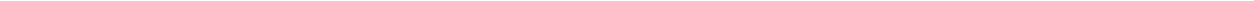
Fig. 7 FGF signaling differentially affects tbx1 + ventricular and BA precursors. a – f Maximum intensity projections of representative tbx1 :EGFP; drl :mCherry DMSO-treated controls or embryos treated with 5 µ M SU5402 from 14 ss to 22 hpf; lateral/dorsal view, anterior to the left. FGF signaling-perturbed embryos show a defect in the tbx1 :EGFP-expressing sheath (arrowhead) at the base of the forming heart tube (outline). g – o Maximum intensity projections of representative hearts of tbx1 :EGFP; myl7 :DsRed2 embryos, DMSO-treated controls ( g – i , n = 5), treated with 5 µ M SU5402 between 14 ss and 24 hpf ( j – l , n = 8), or treated with 2 µ M SU5402 continuously from 14 ss ( m – o , n = 3); ventral views, anterior to the top, outlines mark the heart. FGF-perturbed embryos retain normal contribution of tbx1 :EGFP-expressing cardiomyocytes to the ventricle upon pulsed or continuous signaling inhibition; ventricle (V), atrium (A), bulbus arteriosus (BA), and asterisks mark the missing BA upon SU5402 treatments. p – r Quanti fi ed ventricle, atrium, and BA area size in SU5402-treated embryos as in g – o . Pulsed (see j – l ) or continuous (see m – o ) FGF signaling inhibition diminishes ventricle size ( p ) and severely reduced to